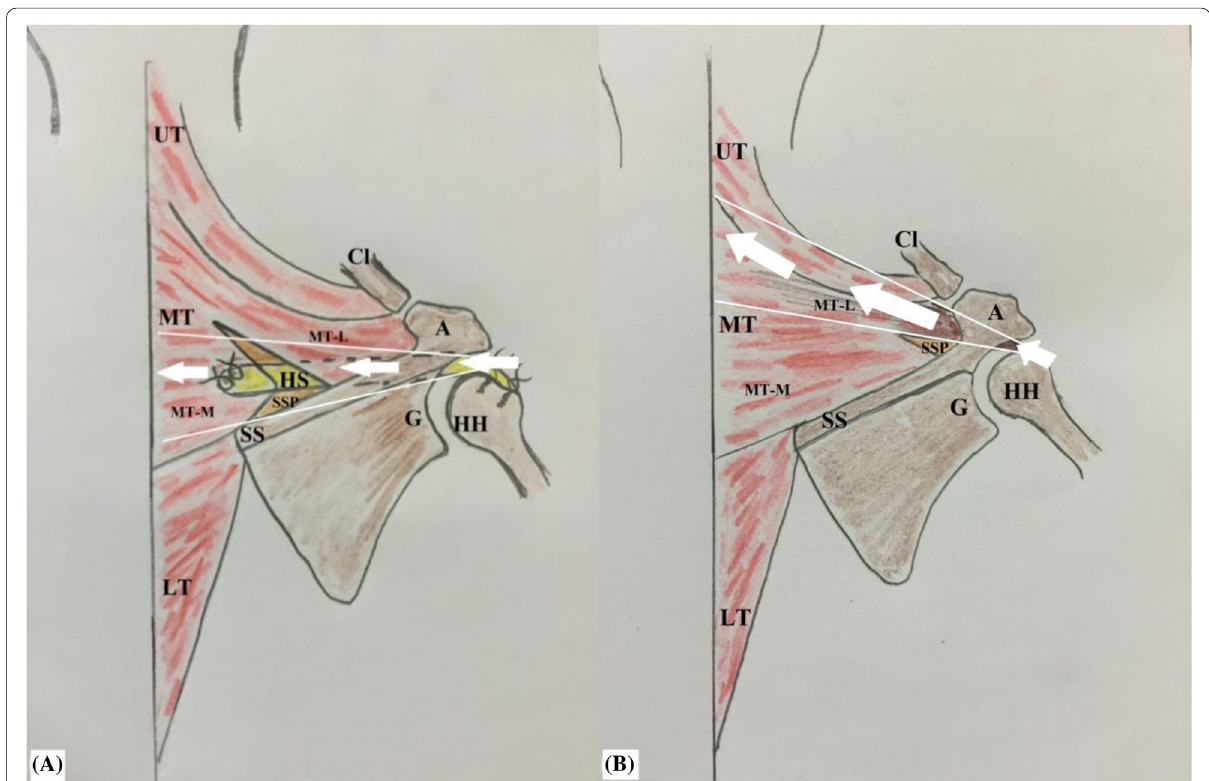
Fig. 14 A, B demonstrate direction of force vector of transferred medial portion of the middle trapezius of the current technique in the right − shoulder. Compared with that of Moroder et al. of transfer of acromial/lateral portion of the middle trapezius insertion, force vector in currently reported technique is more‑collinear with that of supraspinatus muscle; A, acromion; C, coracoid; Cl, clavicle; G, glenoid, HH, humeral head; HS, hamstring sheet; LT, lower trapezius; MT, middle trapezius; MT‑L, middle trapezius (lateral insertion); MT‑M, middle trapezius (medial insertion); SS, scapular spine; SSP, supraspinatus muscle